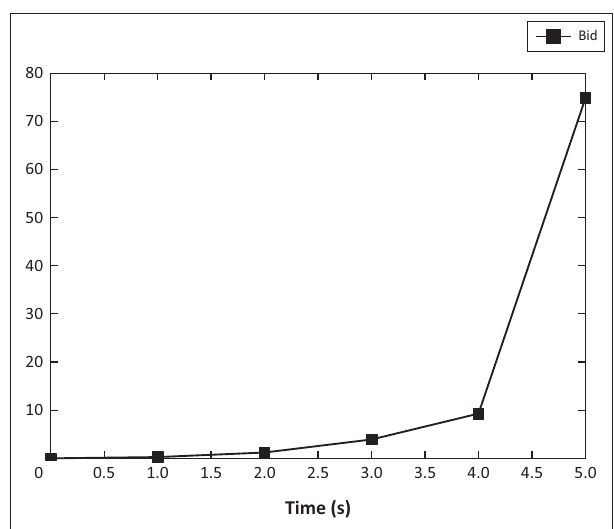
FIGURE 4: Plot of B